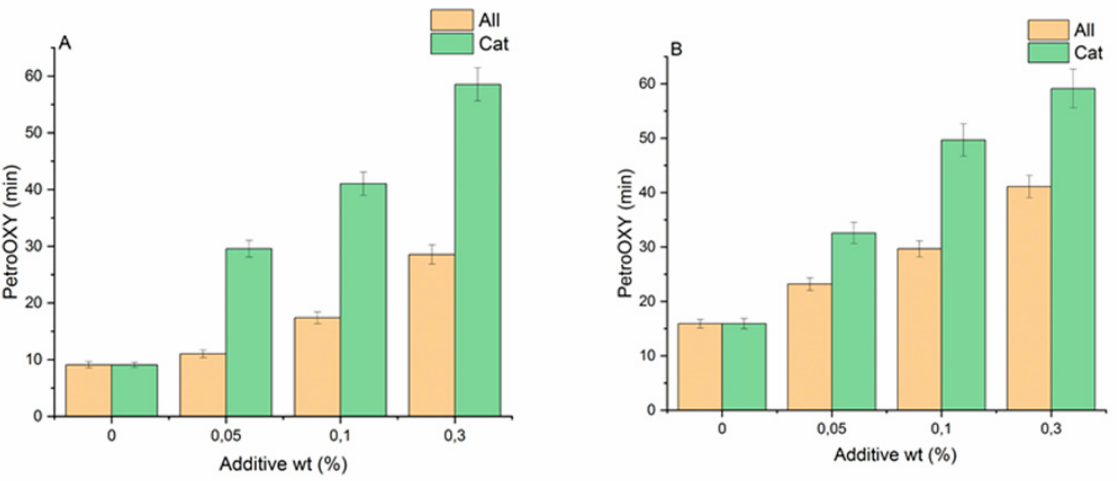
Figure 6. Variation of PetroOXY induction time (min) for rapeseed biodiesel ( A ) and sunflower biodiesel ( B ) without and in the presence of two additives (All = 4-allyl-2,6-dimethoxyphenol; Cat = cathecol).